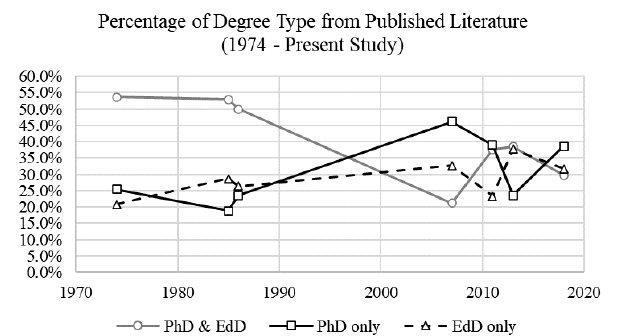
Figure 2. Percentage of Degree Type from Published Literature Between 1974 and